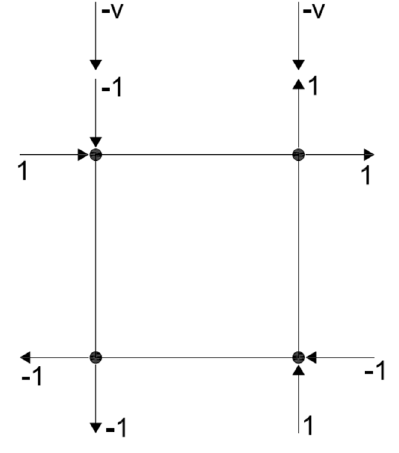
Figure 9. Diagram of loading for the CVL formulation.